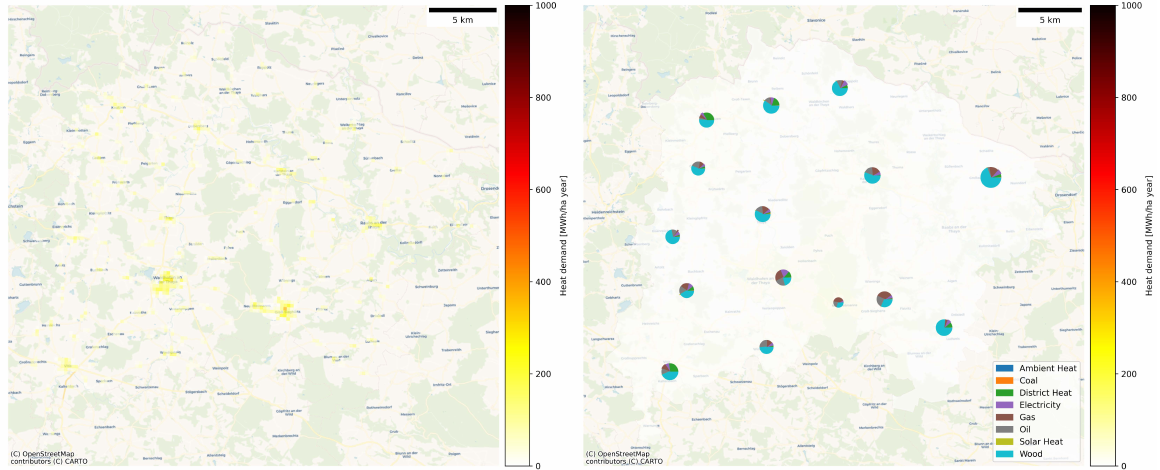
Figure 7. Spatial distribution of the heat demand density per grid cell ( left ) and energy carrier distribution related to the required heat demand per municipality ( right ) in Waidhofen.